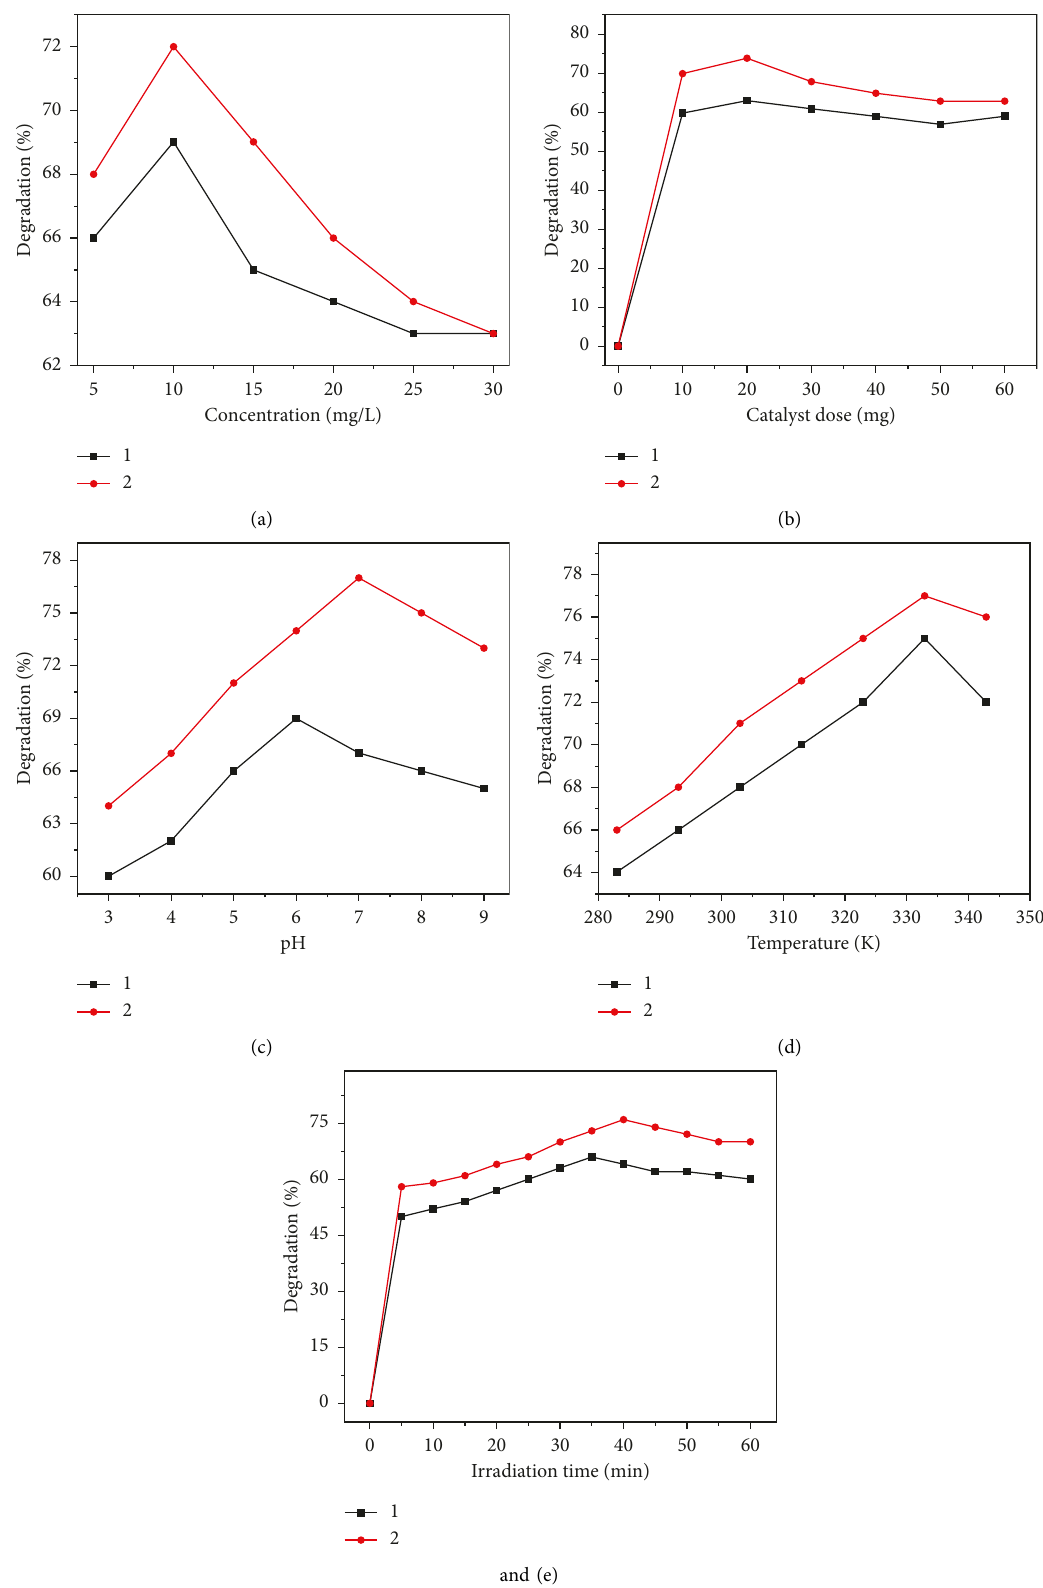
Figure 8: Effect of various photocatalytic parameters. (a) Initial concentration of dye, (b) catalyst dose, (c) pH, (d) temperature, and (e) irradiation time on (c) the degradation efficiency of complexes (1) and